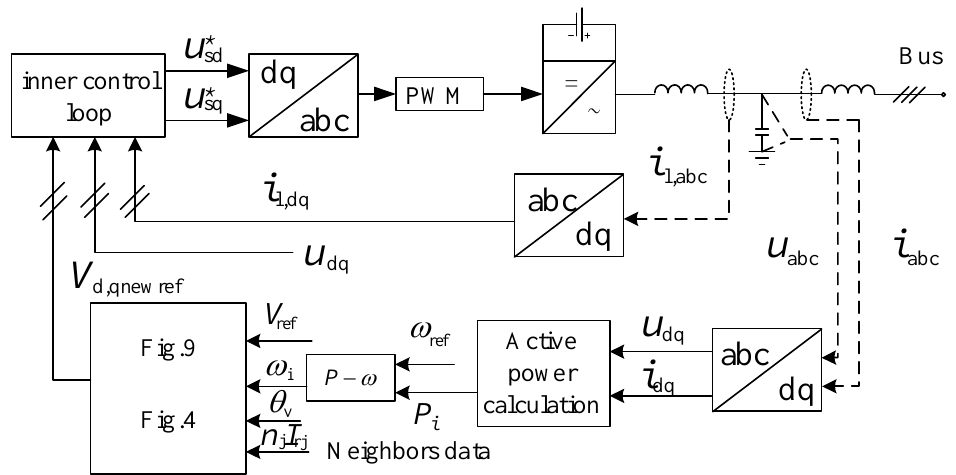
Figure 10. Block diagram of the entire system control scheme.